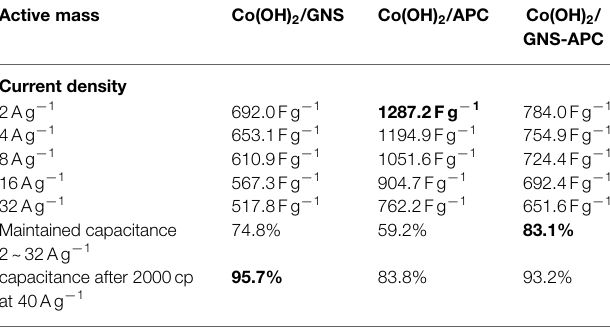
TABLE 1 | Electrochemical properties of Co(OH) 2 /GNS, Co(OH) 2 /APC and Co(OH) 2 /GNS-APC